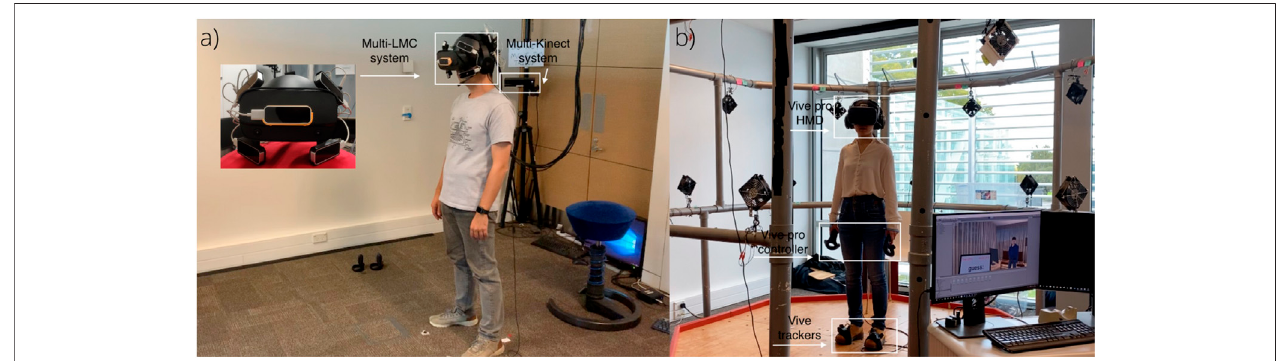
FIGURE1| Thetwoavatarcontrolsystemsusedintheexperiment: (A) Highlyexpressiveavatarcontrolsystemand (B) lowexpressiveavatarcontrolsystem(Note: extra items shown in these pictures, e.g., fans, were not used in this study).